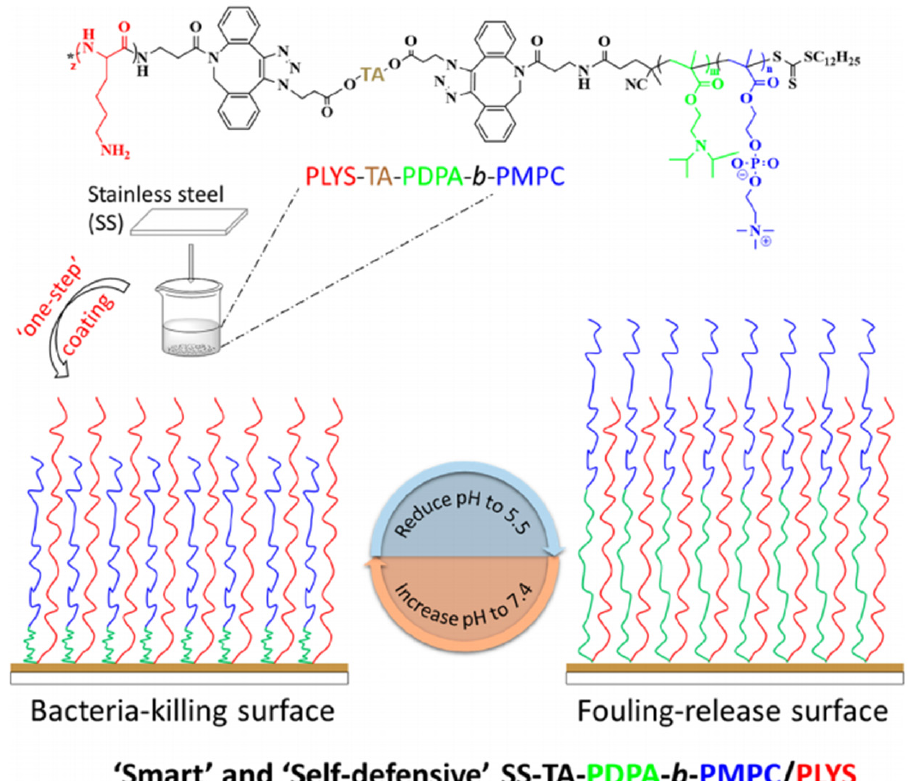
Figure 18. Chemical structure of tannic acid (TA)-scaffolded polymer and a schematic illustration of “one-step” deposition for “smart” and self-defensive TA-scaffolded binary polymer brushes coating. Reprinted with permission from [211]. Copyright 2020 American Chemical Society.